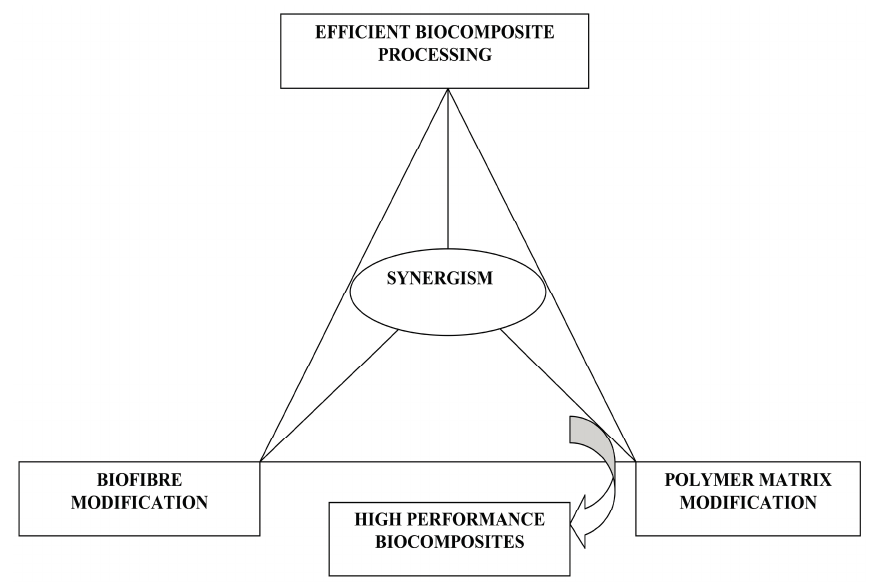
Figure 3. Tricorner approach in designing of high performance biocomposites. Reprinted with permission from Elsevier, 2008